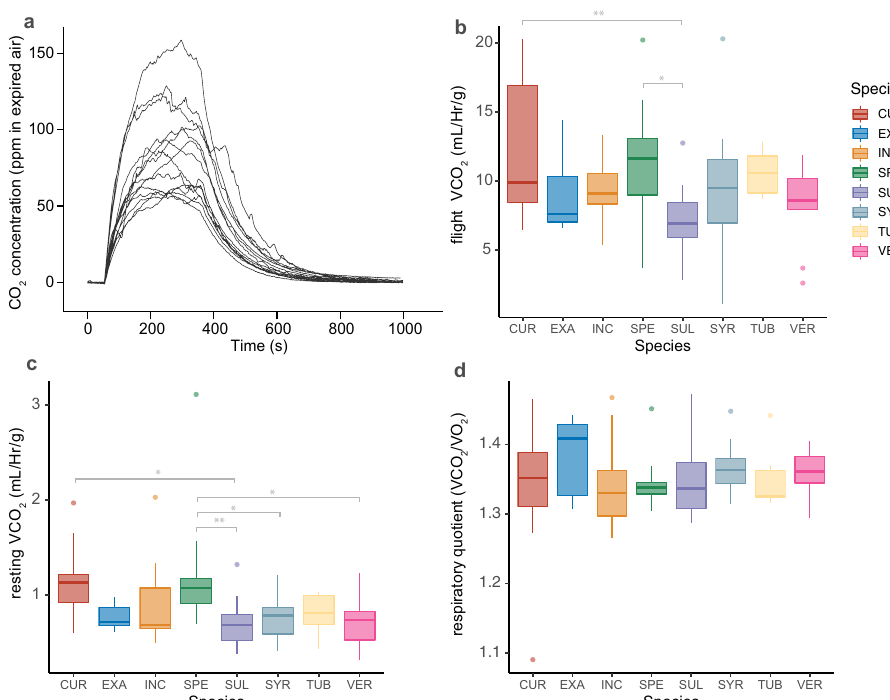
Fig. 2 Results from respiration assays of Monarchs on each milkweed species. a Raw CO 2 traces produced by monarchs fl ying in a respiratory chamber for 5 min; traces for adults reared on A. syriaca shown only. b Body mass normalized adult fl ight metabolic rate and c resting metabolic rate, and ( d ) respiratory quotient (RQ) as a function of larval host plant. CUR, A. curassavica; EXA, A. exaltata; HIR, A. hirtella; INC, A. incarnata; LAE, C. laeve; SPE, A. speciosa; SUL, A. sullivantii; SYR, A. syriaca; TUB, A. tuberosa; VER, A. verticillata; top horizontal bar in box represents third quartile, followed by median and fi rst quartile; whiskers indicate data range. Connecting bars indicate signi fi cant post-hoc LS means comparisons (Tukey